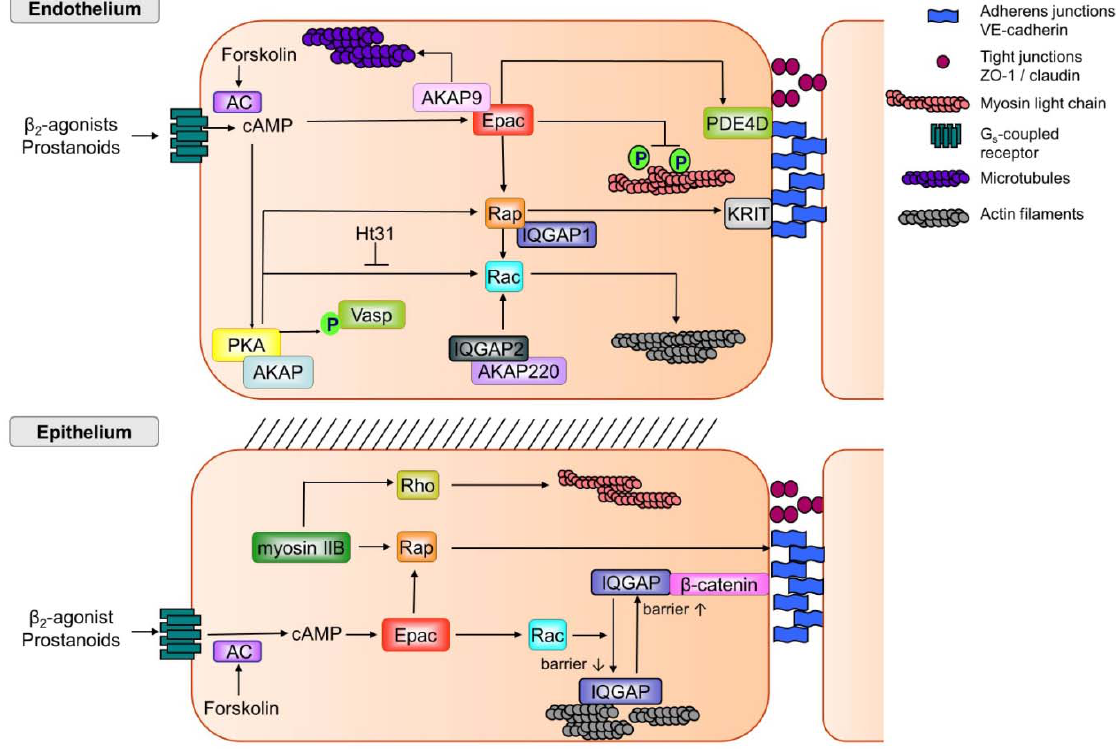
-agonists and prostanoids 2